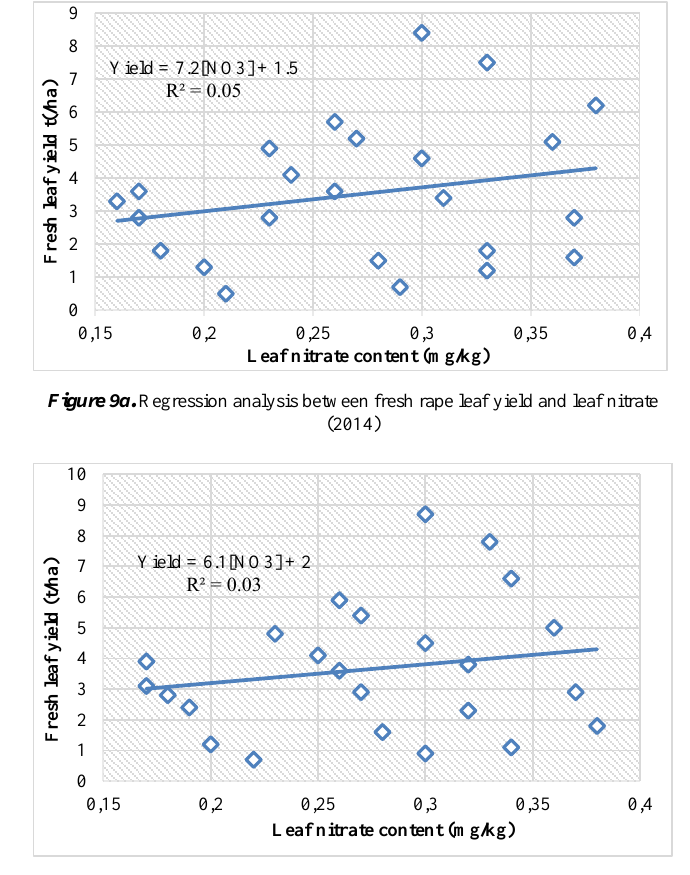
Figure 9b. Regression analysis between fresh rape leaf yield and leaf nitrate (2015)